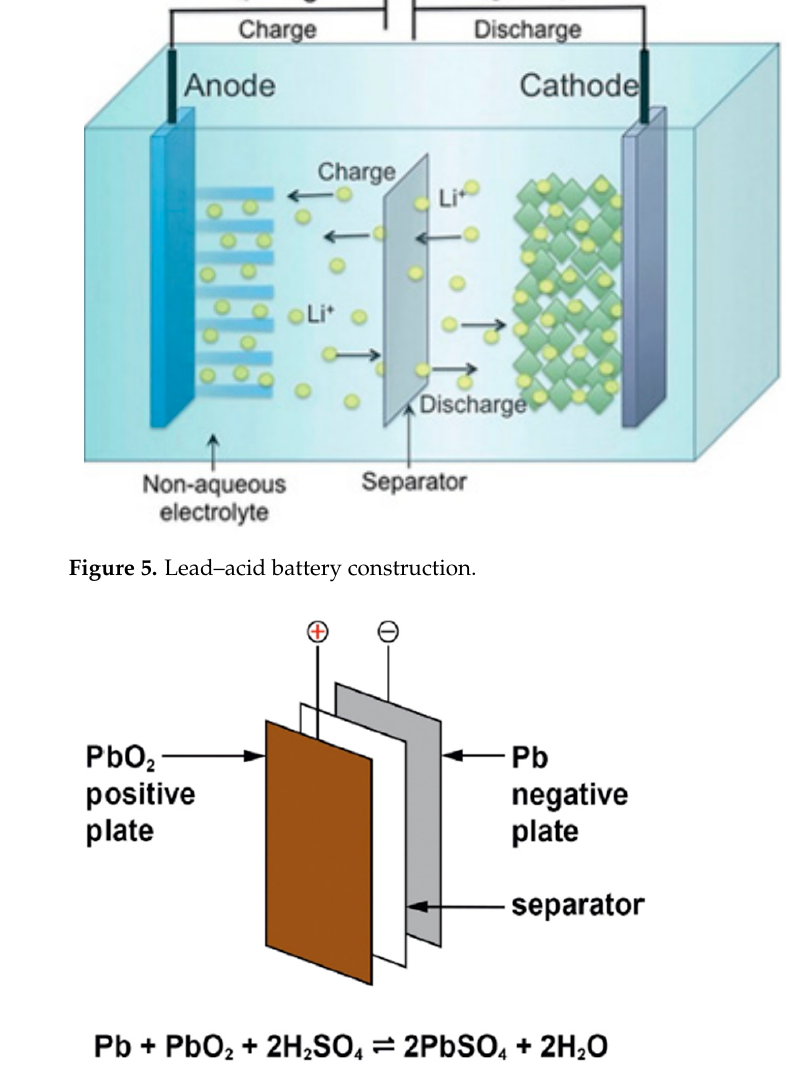
Figure 6. Chemistry of lead–acid battery.